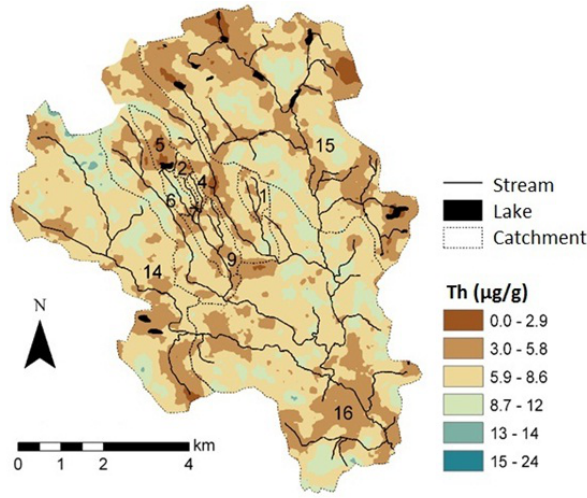
Fig. 2. Concentration of thorium in surface soils in the Krycklan catchment. The investigated subcatchments are indicated by num- bers. (SGU, consent Dnr: